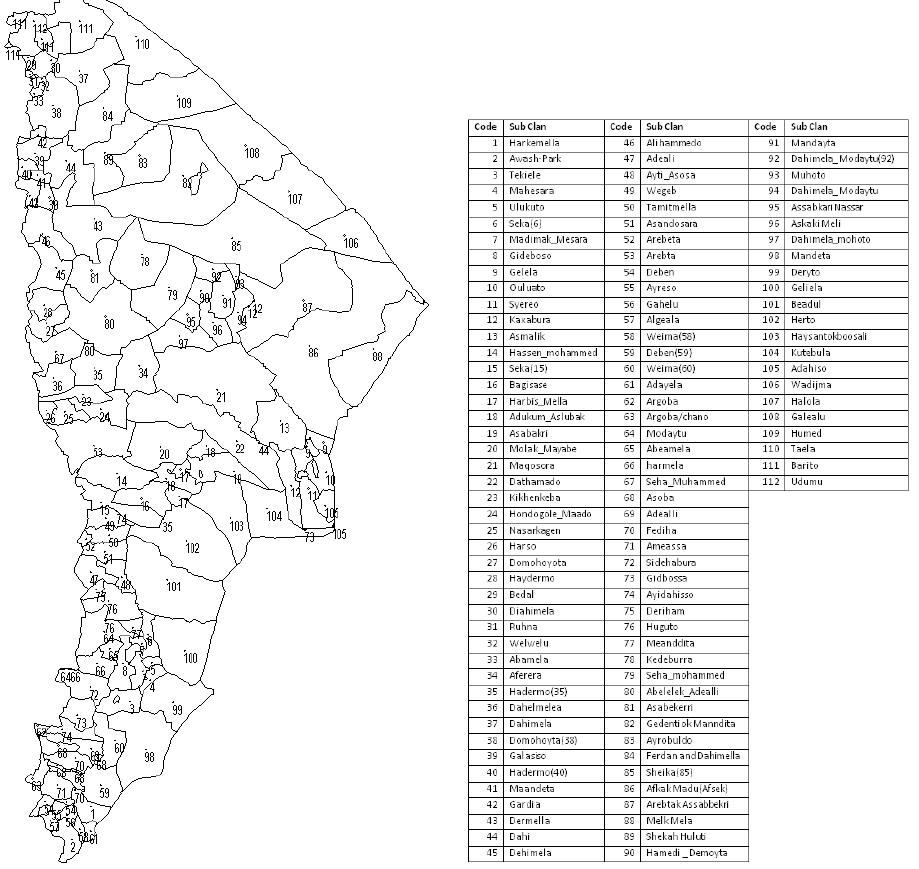
Figure 2. The base map of the sub-clan areas (scale Figure 7. Surplus (panel a ) and deficit (panel b ) of annual fodder supply in case of no migration expressed in TLU (scale 1:6,500,000).